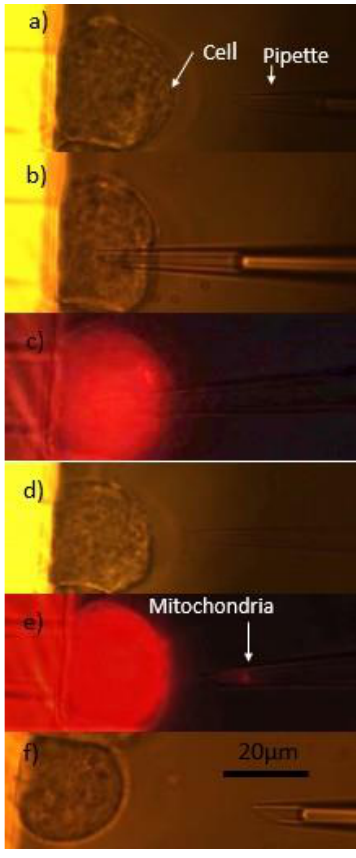
Fig. 10. Biopsy of mitochondria. a) micropipette alignment with the selective position in the cell. b) penetration into the cell. c) aspiration of mitochondria Figure 8. Snapshots of extraction of cell mitochondria. ( a ) Detection of position coordinates of the biopsied mitochondria; ( b ) moving the micropipette to the mitochondria; ( c ) aspiration of mitochondria; ( d , e ) moving the micropipette out of the cell; and ( f ) releasing the mitochondria from the micropipette. Reproduced with permission from